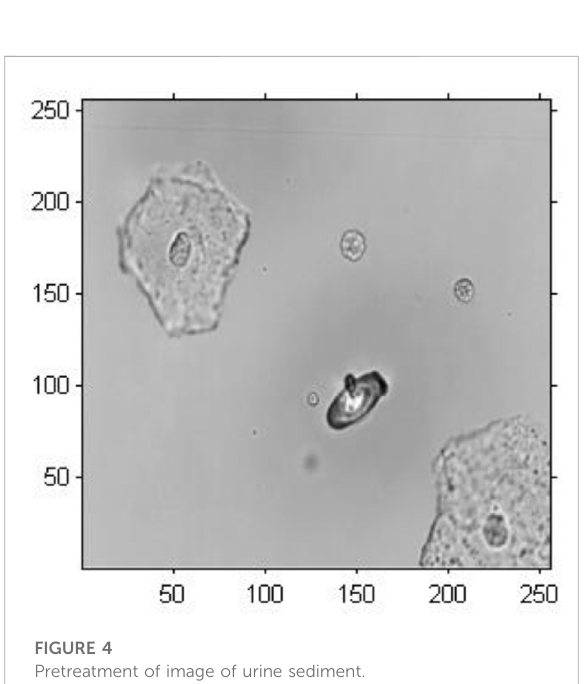
FIGURE 4 Pretreatment of image of urine